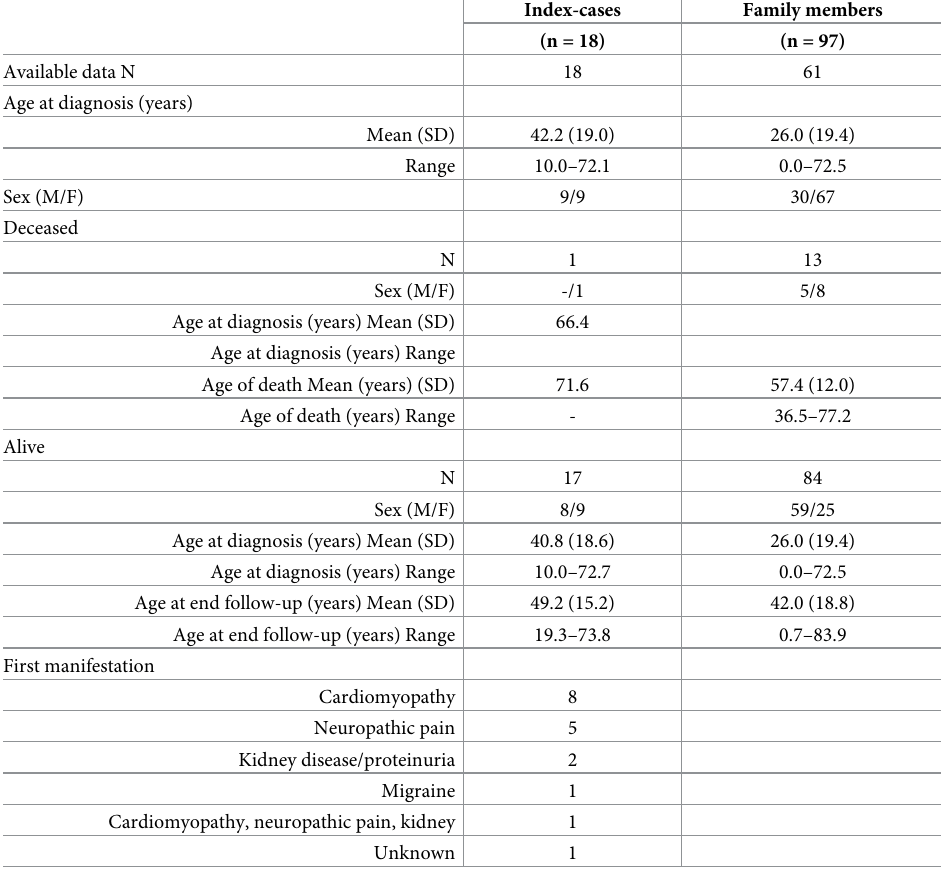
Table 2. Illustration of the affected individuals of the Danish Fabry cohort at diagnosis and/or baseline assess- ment from 2001 onwards and at the end of the study period. Index patients and their family members were described in terms of age at diagnosis, sex, dead/alive at end of study, age at end of the study or age at death, no contact and first organ manifestation of the index